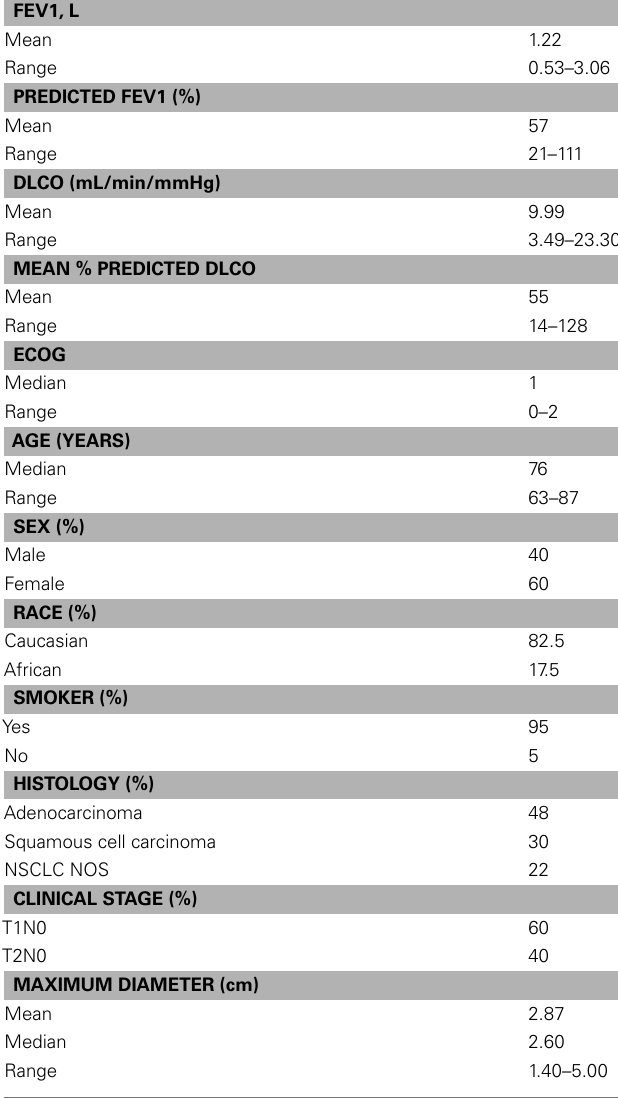
Table 2 | Patient and tumor characteristics.